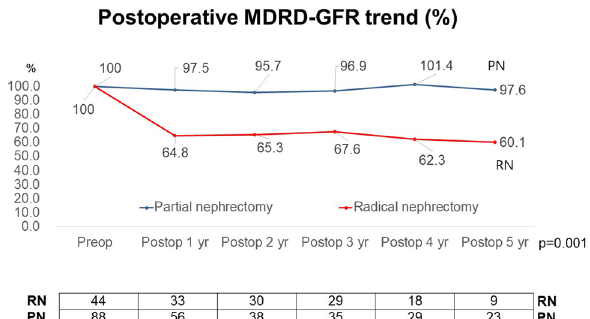
Figure 1. Postoperative renal function trends in glomerular filtration rate (GFR) preservation rates after radical nephrectomy and partial nephrectomy between the